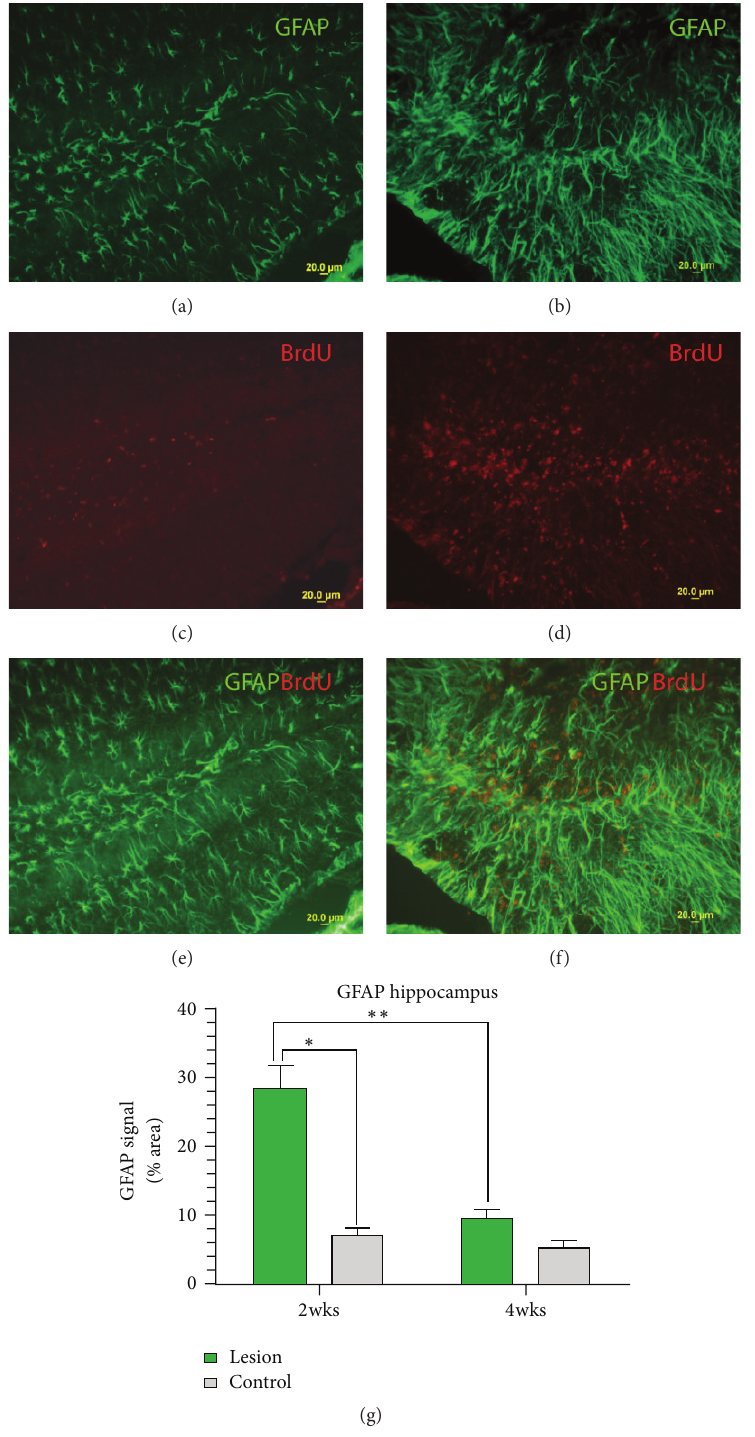
Figure 4: Astrocytosis in hippocampus indicated by GFAP immunoreactivity. Panels on the left ((a), (c), and (e)) depict the unlesioned control side; panels (b), (d), and (f) show the lesioned side. (a), ( b ) = GFAP (green channel); (c), ( d ) = BrdU (red channel); (e), (f) merged channels (GFAP and BrdU). (g) Astrocytosis measured as extent of GFAP immunoreactivity (mean % area of field) was increased 6 times that of control ( 𝑛 = 3 mice at 2wks; 3 mice at 4wks; 6 sections per mouse). 2-way ANOVA showed that both treatment and time contribute significantly to the variance. Signal was significantly higher on lesioned side at 2 weeks. At 4 weeks, the mean signal had declined significantly. ∗ 𝑃 < 0.001 ; ∗∗ 𝑃 < 0.001 using Bonferroni correction for multiple